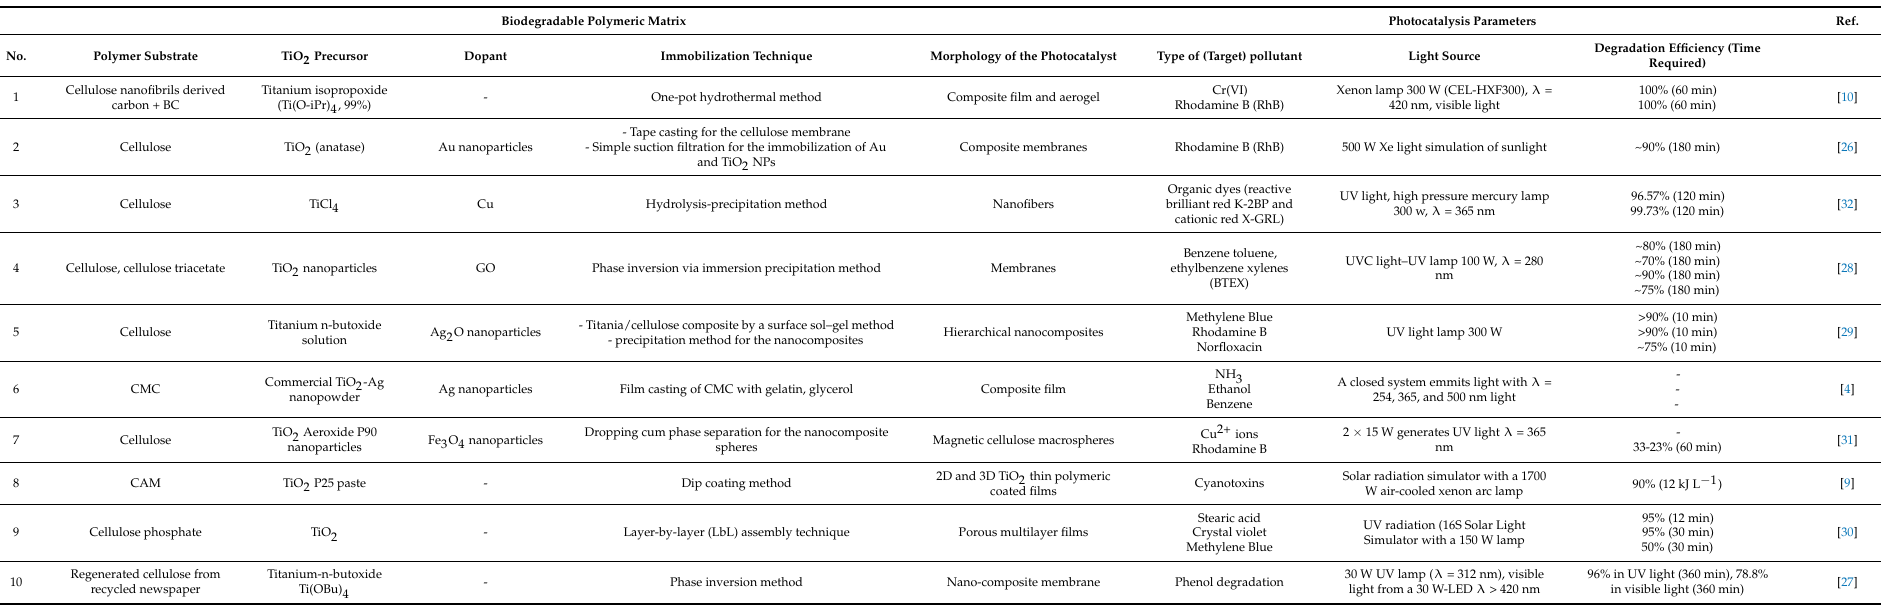
Table 2. Summary of the cellulose-supported TiO 2 photocatalysts enclosed in the presented